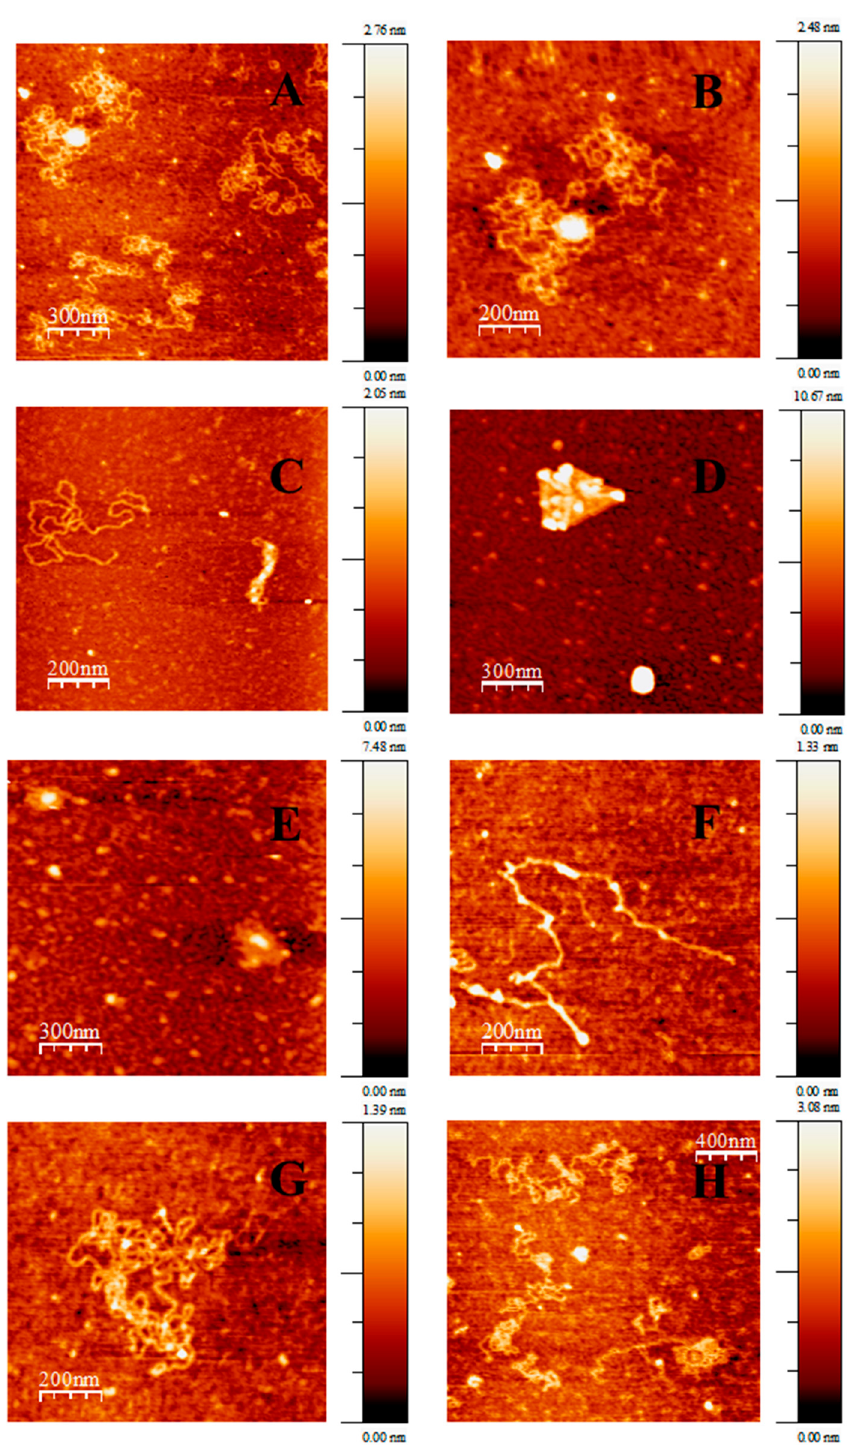
Figure 3. AFM topography images of DNA/5-Fu and C i complexes adsorbed on 3-aminopropyltriethoxilane (APTES)-modified mica surface in a cacodylate buffer (I = 1.63 mM and pH = 7.4; C DNA = 0.3 µM, C 5-FU = 0.25 µM) under different reaction conditions: ( A , B ) DNA/5-Fu complex, C Au@16-Ph-16 = 0 pM. ( C ) Intermediates of compaction; C Au@16-Ph-16 = 1.10 pM. ( D , E ) Ci complexes at a compact stage; C Au@16-Ph-16 = 11.1 pM. ( F , G ) Intermediates of decompaction; C Au@16-Ph-16 = 34.0 pM. ( H ) Ci complexes at the decompacted stage; C Au@16-Ph-16 = 50.0 pM.